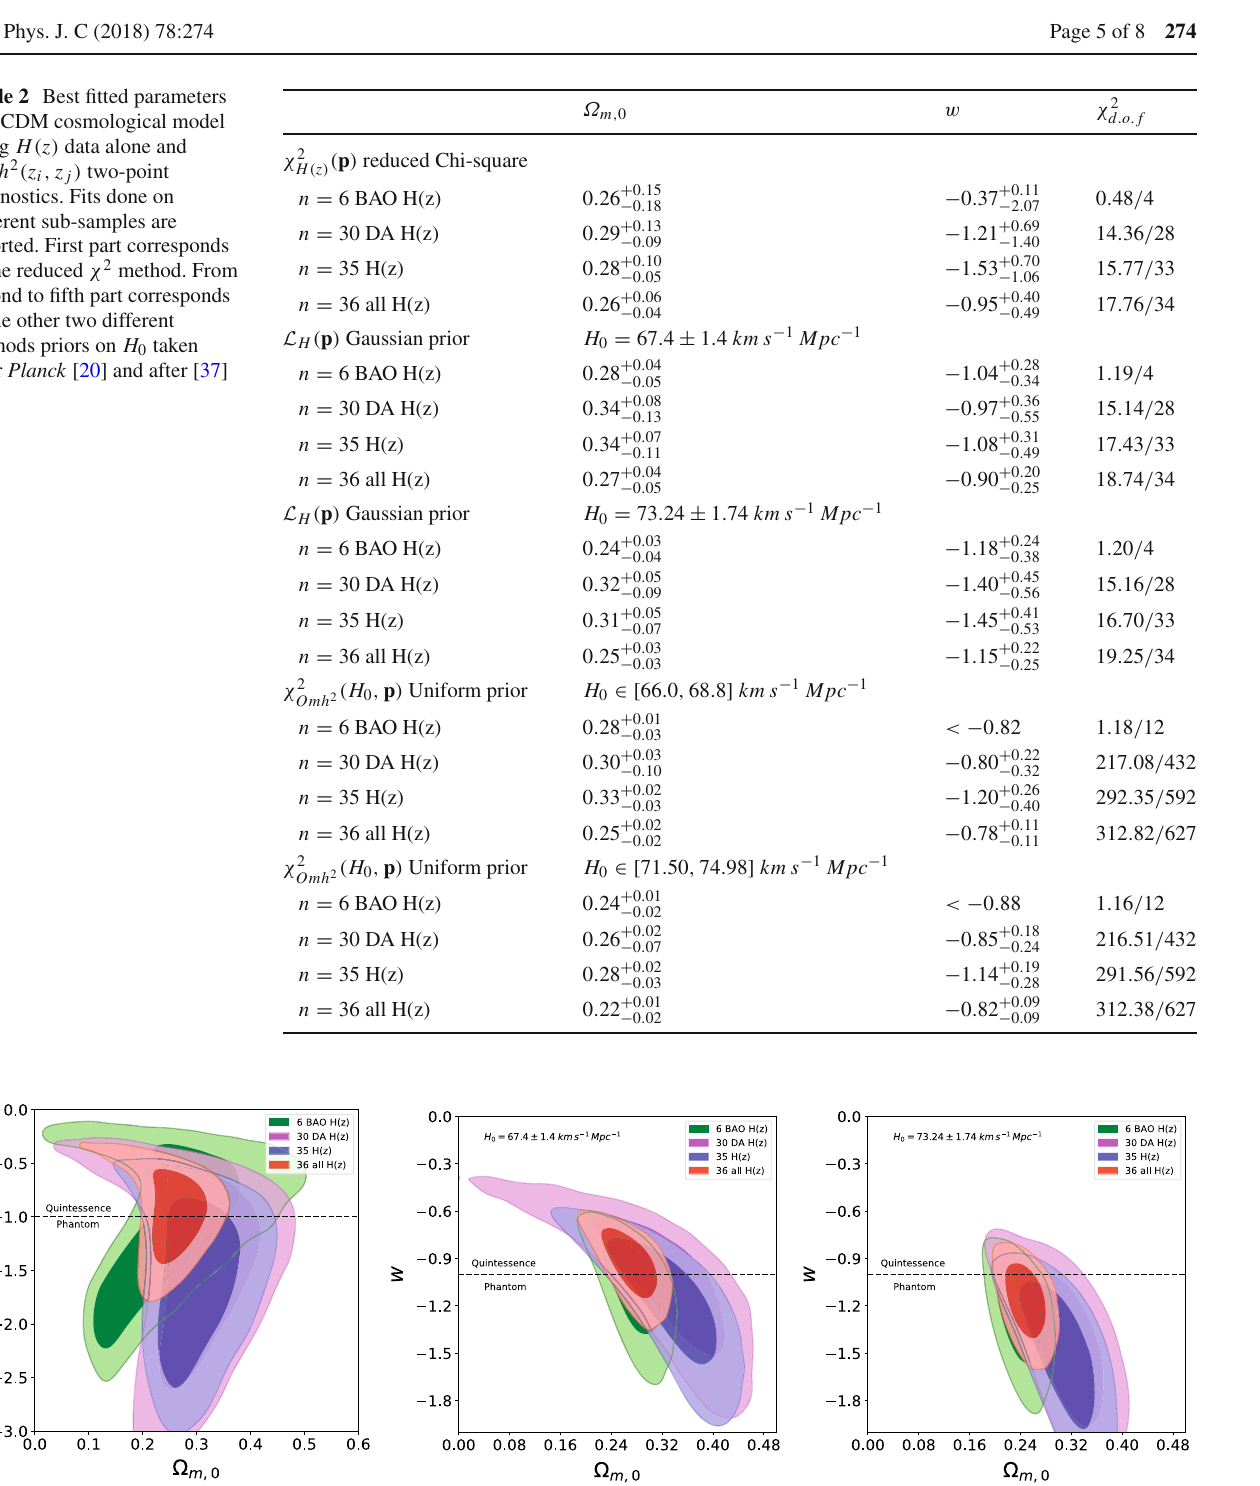
withGaussianprior H 0 = 67 . 4 ± 1 . 4 km s − 1 Mpc − 1 from Planck result [20] and lower right one with prior H 0 = 73 . 24 ± 1 . 74 km s − 1 Mpc − 1 from local measurements